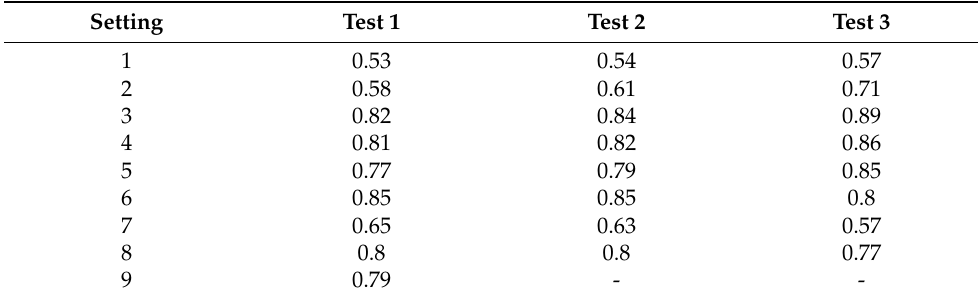
Table 6. Calculation of the harmonic mean (F) for RS runs. Setting Test 1 Test